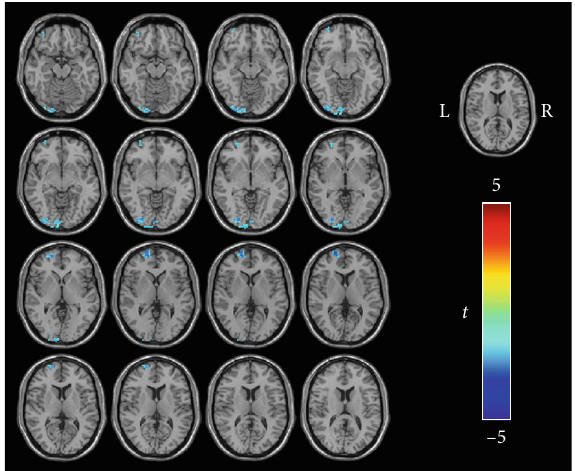
Figure 5: Regions showing decreased FC in the tinnitus patients when the left precuneus was used as the seed (voxelwise P < 0 : 001 , FWE-corrected clusterwise P < 0 : 05 ). In the tinnitus patients, the left inferior occipital gyrus, left calcarine cortex, and left superior frontal gyrus showed decreased FC with the left precuneus compared with those in the healthy controls. The color bar indicates the t value of independent two-sample t -tests between the groups. DAN: dorsal attention network; FC: functional connectivity; FWE: familywise error; L: left; R: